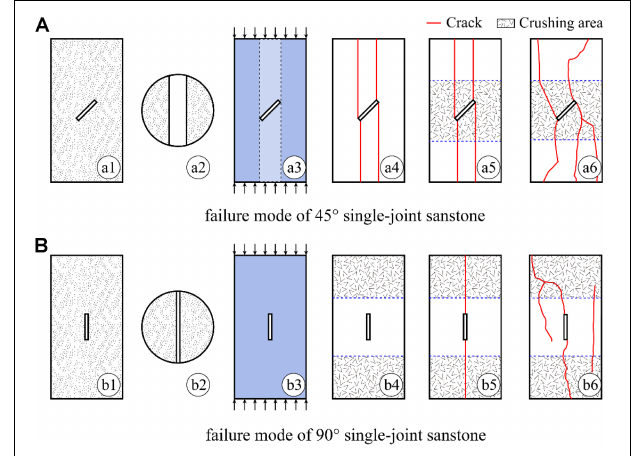
FIGURE 7 | Failure modes of the 45 ◦ and 90 ◦ single-joint sandstone samples.